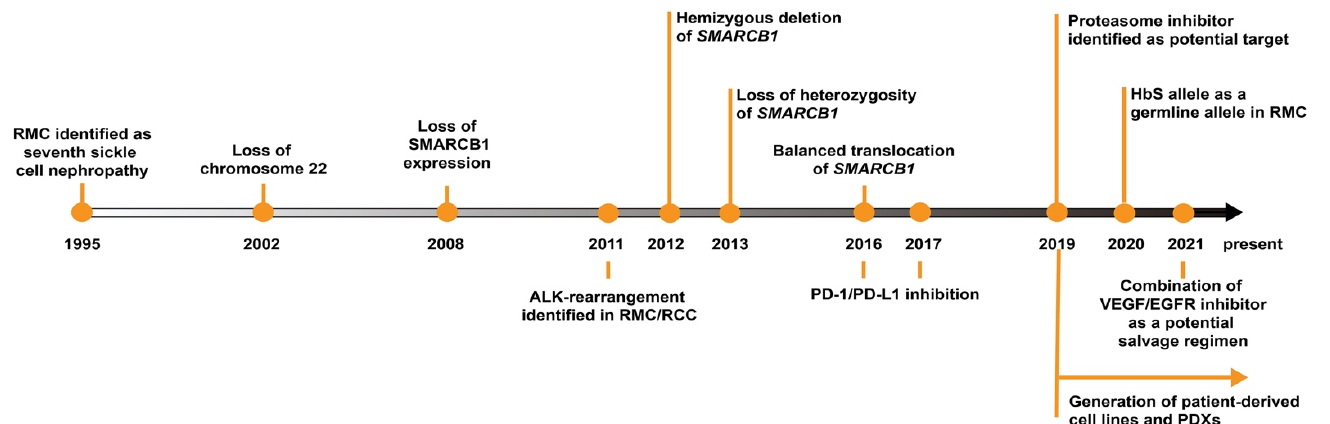
Figure 2. Timeline of RMC research over the past two decades.